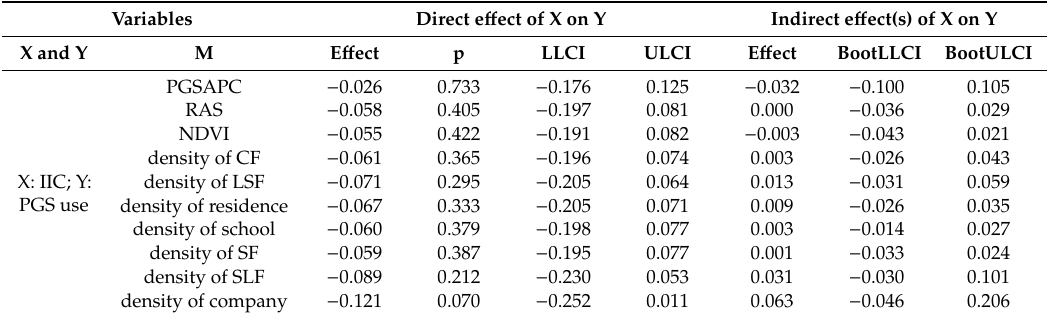
Table 4. The details of Model 2 about the direct and indirect e ff ect of IIC on PGS